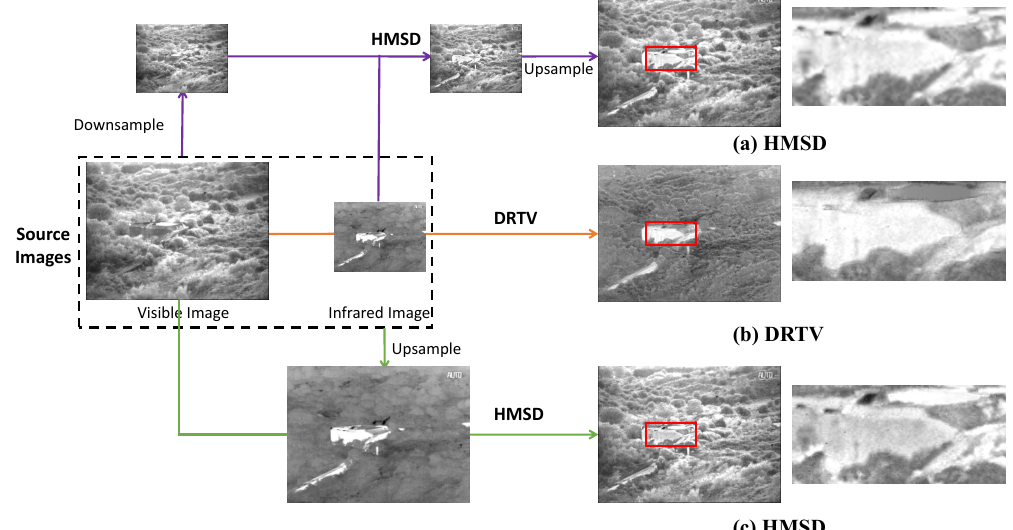
Figure 1. A typical example for fusing infrared and visible images of different resolutions through ( a ) downsampling the visible image; ( b ) our method; and ( c ) upsampling the infrared